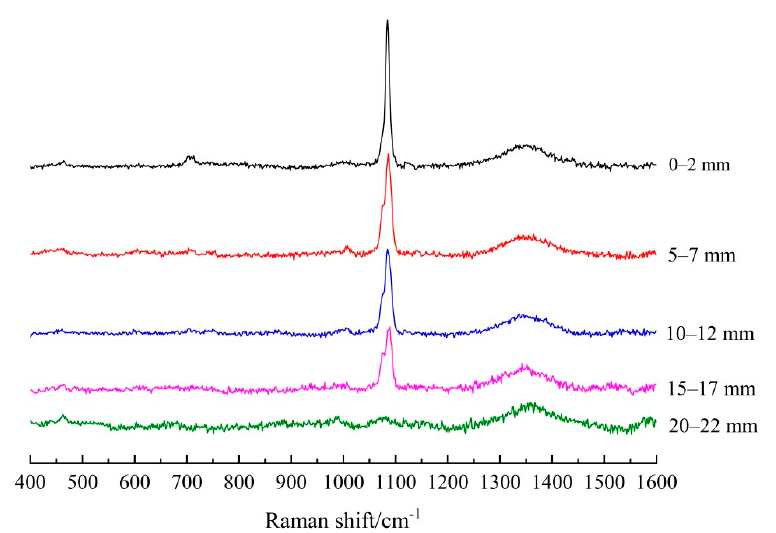
Figure 4. Raman spectra (after subtracting the background) of the powders collected at five depths of carbonated FA/PC paste samples.